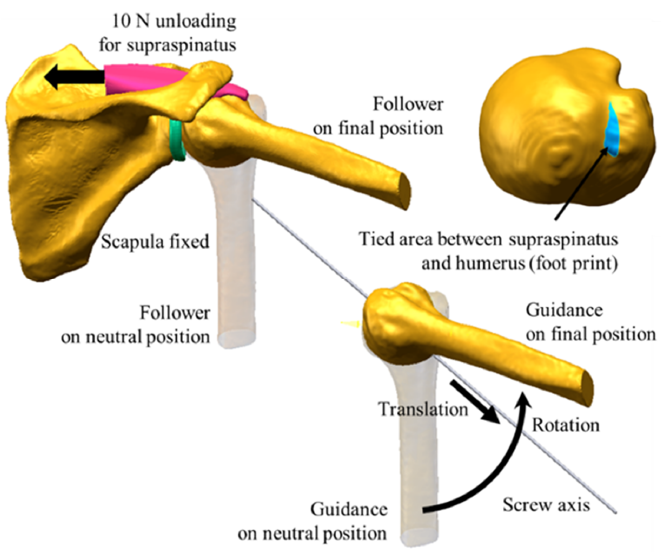
Figure 5. Finite element simulation environment.